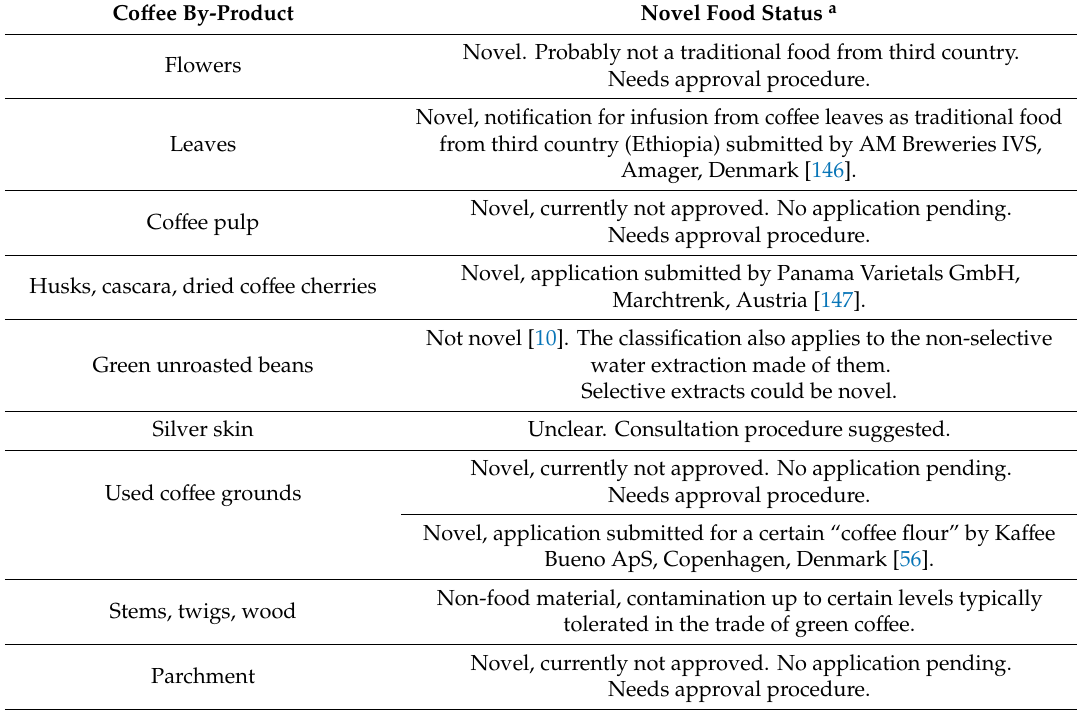
Table 2. Co ff ee by-products and assessment of their novel food status considering regulation (EU) No 2015 /